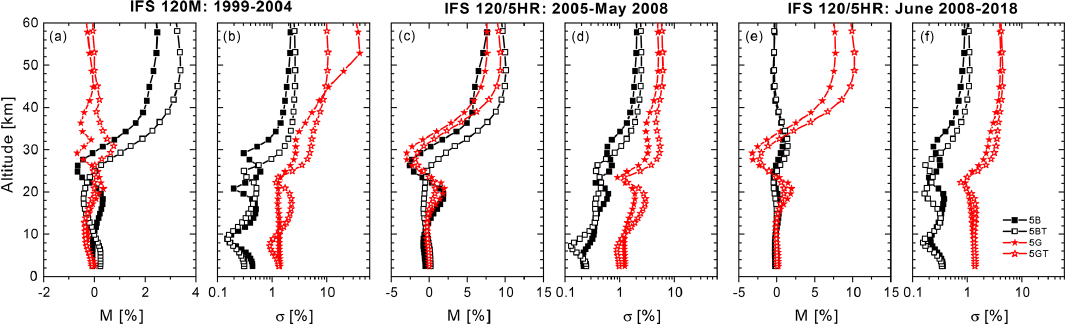
Figure 5. Summary of the O 3 profile comparison for the set-ups 5B, 5BT, 5G, and 5GT with respect to 5A and 5AT for the periods 1999– 2004, 2005–May 2008 and June 2008–2018, and for the entire time series (1999–2018). Panels (a) , (c) , and (e) display the vertical profiles of the median ( M ) RD (5X and 5XT to 5A and 5AT, in %) for the three periods, respectively. Panels (b) , (d) , and (f) are the same as (a) , (c) , and (e) but for the standard deviation of RD distributions ( σ , in